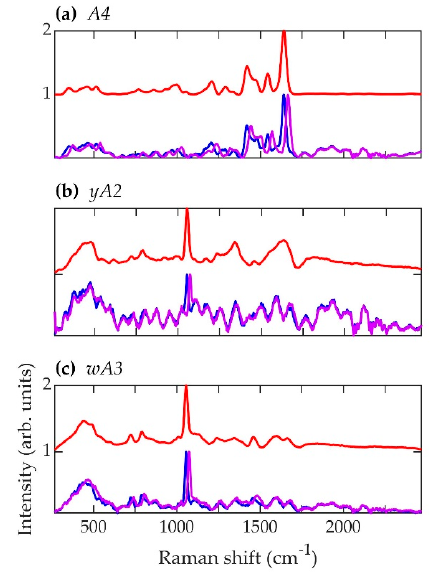
Figure 6. Spectra corresponding to A. nidulans strains ( a ) A4, ( b ) yA2 , and ( c ) wA3 . Blue (~784.3 nm laser excitation) and purple (~785.5 nm laser excitation) curves are the average normalized background-subtracted raw spectra, while the red curves are average retrieved pure Raman spectra.